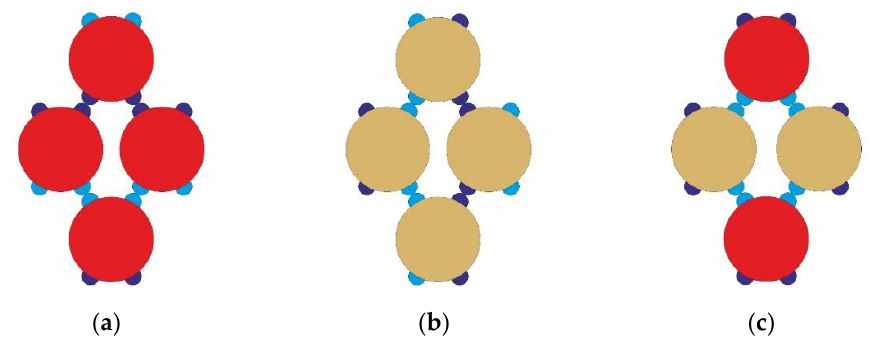
6 of 13 Figure 1. Patchy particles type I ( left ) and patchy particles type II ( right ). Strong and narrow SN patches (deep blue) and weak and wide WW patches (light blue) are distributed for both types in a